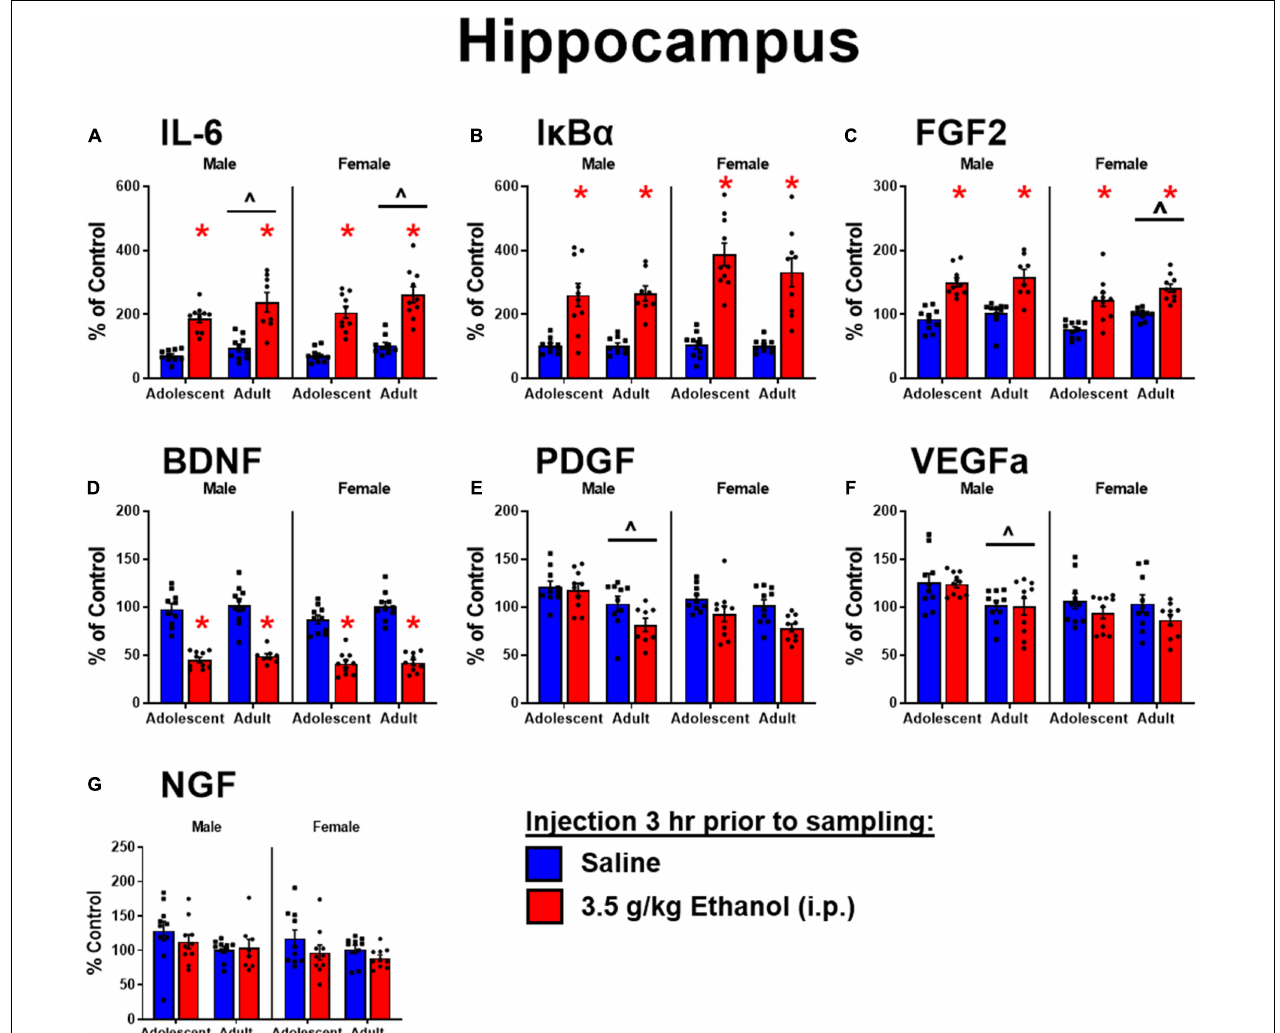
FIGURE 2 | Ethanol-induced gene expression in adolescents and adults. Gene expression of IL-6 (A) , I κ B α (B) , FGF2 (C) , BDNF (D) , PDGF (E) , VEGF α (F) , and NGF (G) in the dorsal hippocampus were assessed in ratsi.p. injection of saline or 3.5 g/kg ethanol. Gene expression data were calculated as a relative change in gene expression using the 2- (cid:49)(cid:49) C(t) method, with (GAPDH) used as a reference gene and the vehicle – saline group serving as the ultimate control for each sex individually. Bars denote group means ± standard error of the mean (represented by vertical error bars). Asterisks (*) signify significant ethanol-induced changes ( p < 0.05), chevron ( ∧ ) indicates main effect of